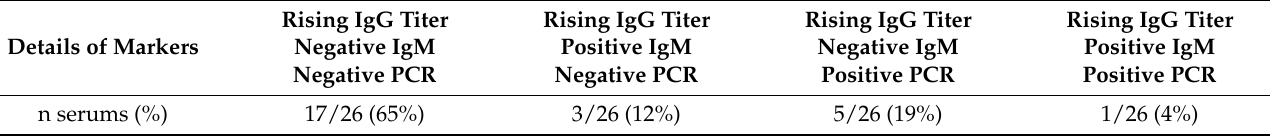
Table 3. Details of serological and molecular markers of active infection in the 26 serum samples of panel 4 (3